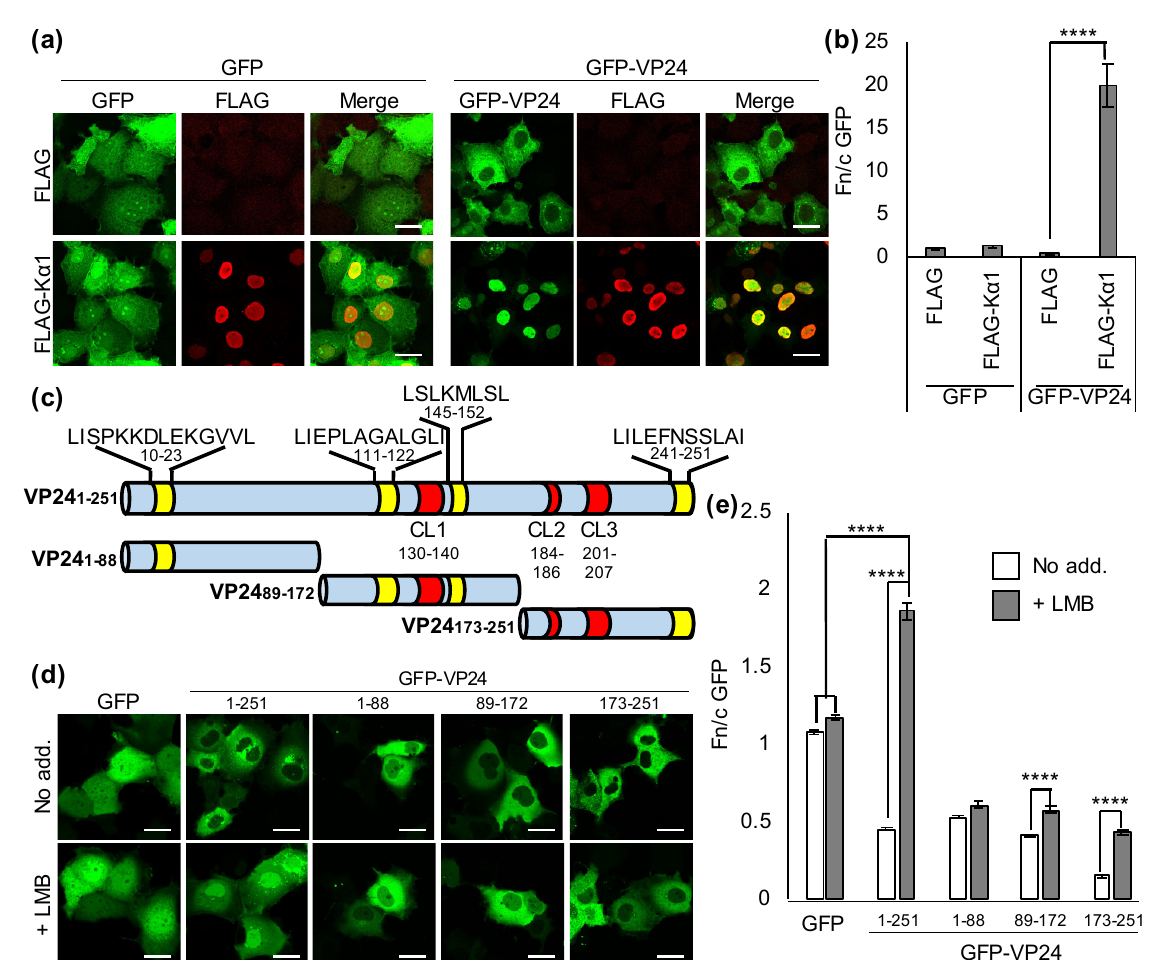
Figure 1. EBOV VP24 undergoes nucleocytoplasmic trafficking. ( a ) COS7 cells co-transfected to express the indicated proteins were fixed 24 h post-transfection before immunofluorescent staining for FLAG (red), and CLSM analysis. Represen- tative images are shown. ( b ) Images such as those shown in ( a ) were analyzed to calculate the Fn/c for GFP (mean ± SEM, n ≥ 52 cells for each condition; data from a single assay representative of three independent assays). ( c ) Schematic of VP24 and truncated proteins generated. Potential NESs are indicated in yellow (sequences shown above). Location of residues that interact with K α 5 in the VP24:K α 5 crystal structure (CL1-3) [9] are shown in red. Numbering indicates positions in full-length VP24. ( d , e ) COS7 cells transfected to express the indicated proteins were treated 24 h post-transfection with or without LMB before live-cell CLSM ( d ) to determine the Fn/c for GFP ( e ); mean ± SEM; n ≥ 31 cells for each condition; data from a single assay representative of three independent assays. ****, p < 0.0001; No add., no addition. Scale bars, 30 µ